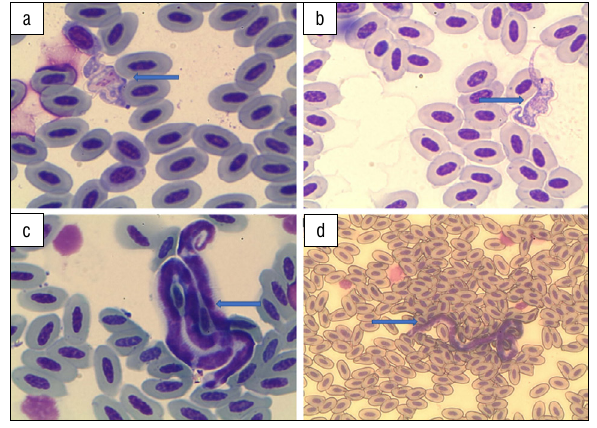
Figure 1: Haemoparasites in avian blood films: Trypanosoma sp. in (a) a red-billed hornbill ( Tockus erythrorhynchus ) at Shingwedzi and (b) a yellow-fronted canary ( Serinus mozambicus ) at Skukuza. (c) and (d) Microfilariae in an African mourning dove ( Streptopelia decipiens ) at